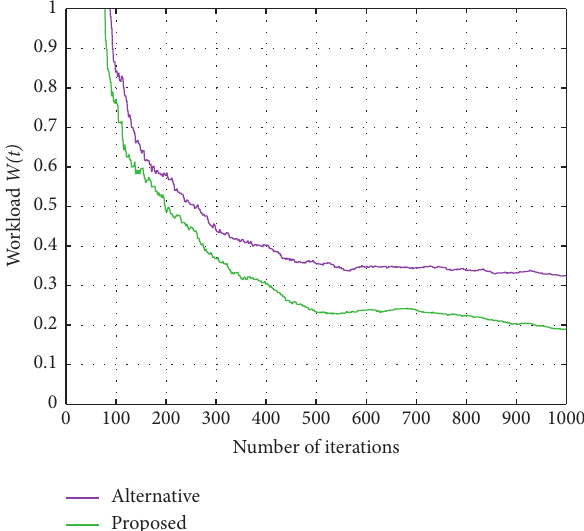
Figure 9: Comparing the performance of the alternative approach with the proposed algorithm in terms of the measure of workload W ( t )